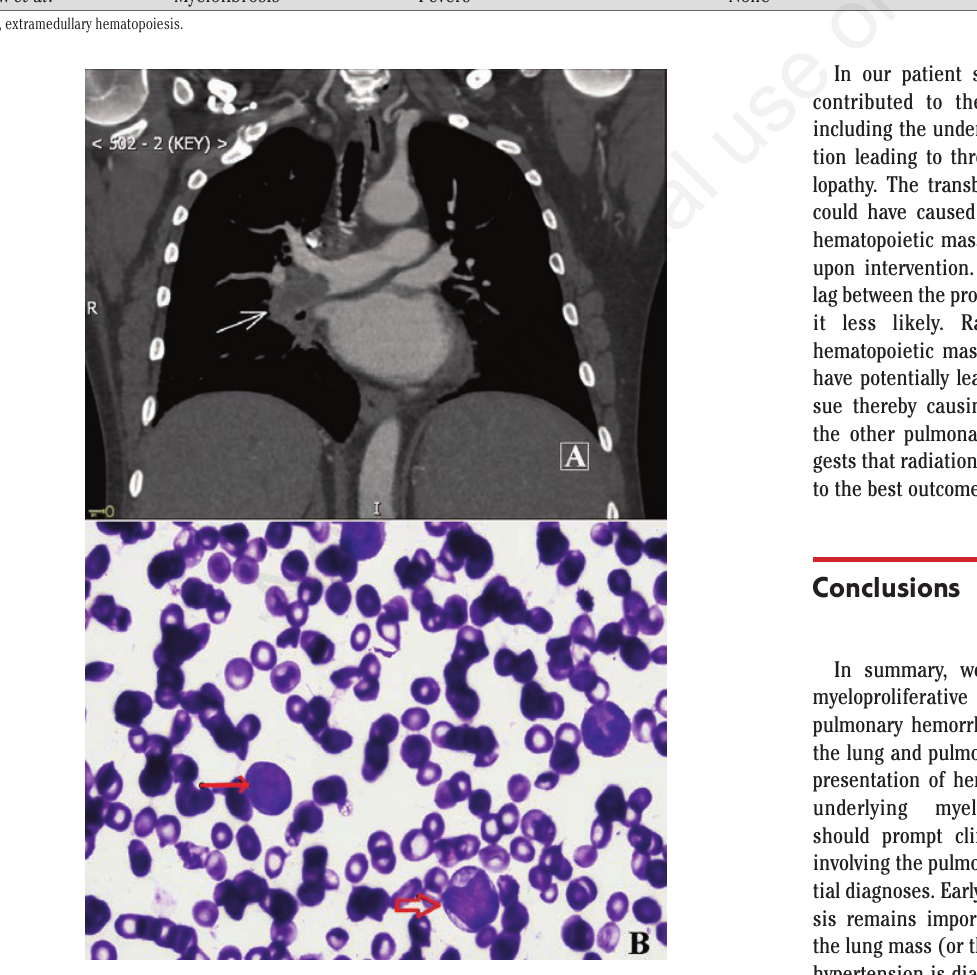
Figure 1. A) Coronal view of post contrast computed tomography imaging of the chest with arrow pointing towards the filling defect within the right pulmonary artery. B) High power view of Hematoxylin and Eosin stain of the endobronchial ultrasound guided aspi- rate of the right pulmonary artery thrombus showing extramedullary hematopoiesis with immature myeloid cells (box arrow) and focally increased areas of blasts (line